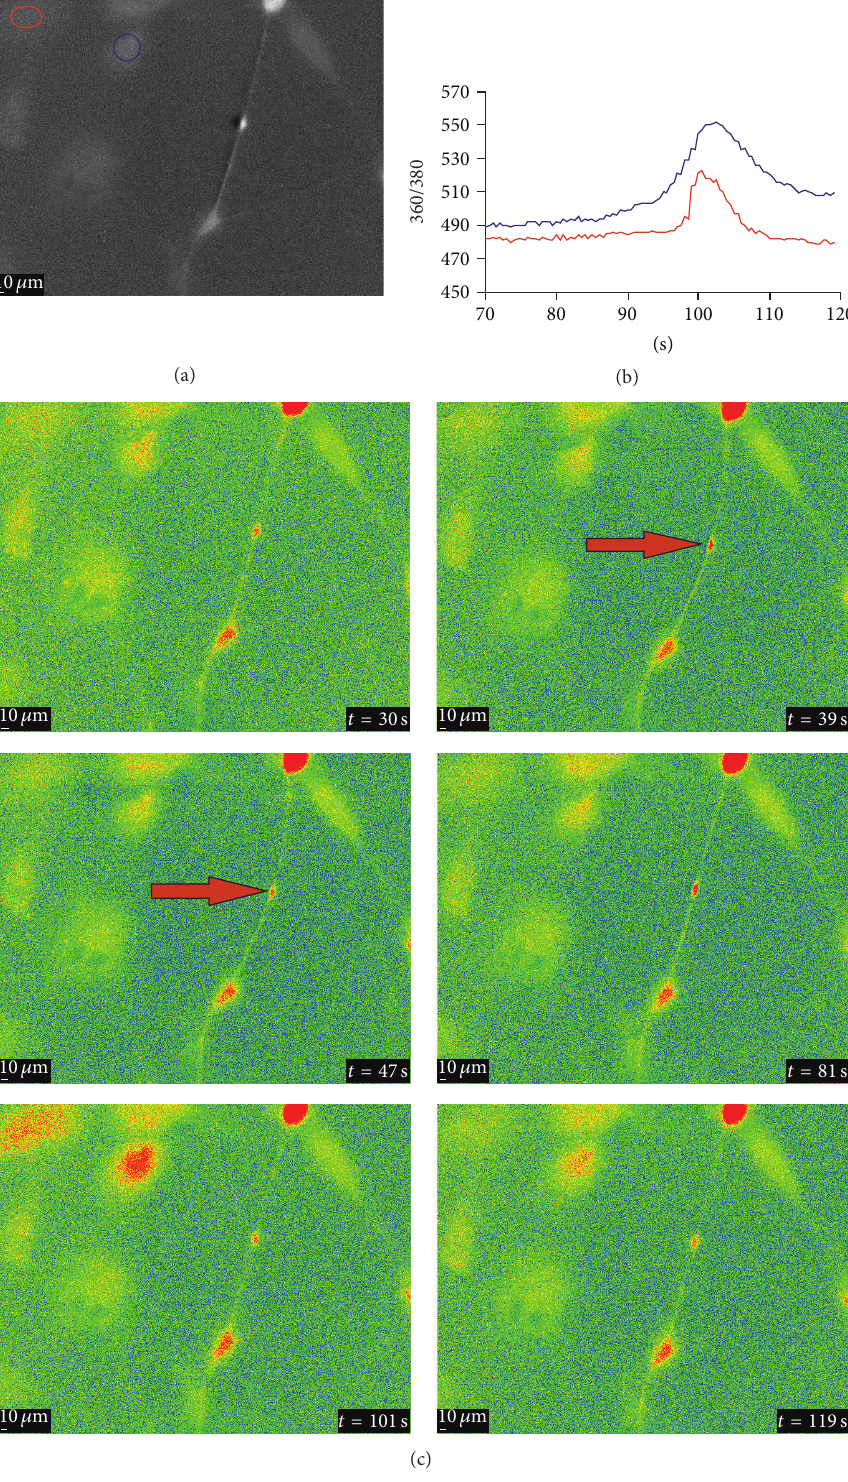
Figure 5: The intercellular dendrite connection strength upon mechanical fluid movement for the nonattached dendrites in aLC explant cultures. The traces (b) represent the time courses of the 360/380 ratio (𝑅) , proportional to [ Ca 2+ ] (ROI) shown in the B&W image(a) in the same colors. (c) A series of the 360/380 ratio images at the time points are indicated. The values for 𝑅 are color coded with blue/green representing low ratio values and yellow/red representing high ratios (explant growth time: 21